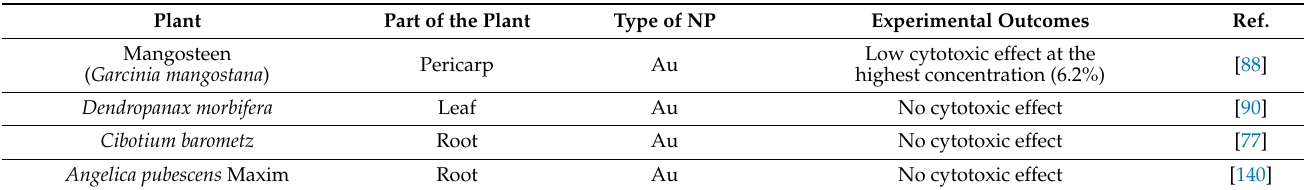
Table 6. Plant-based gold and silver nanoparticles as drug delivery